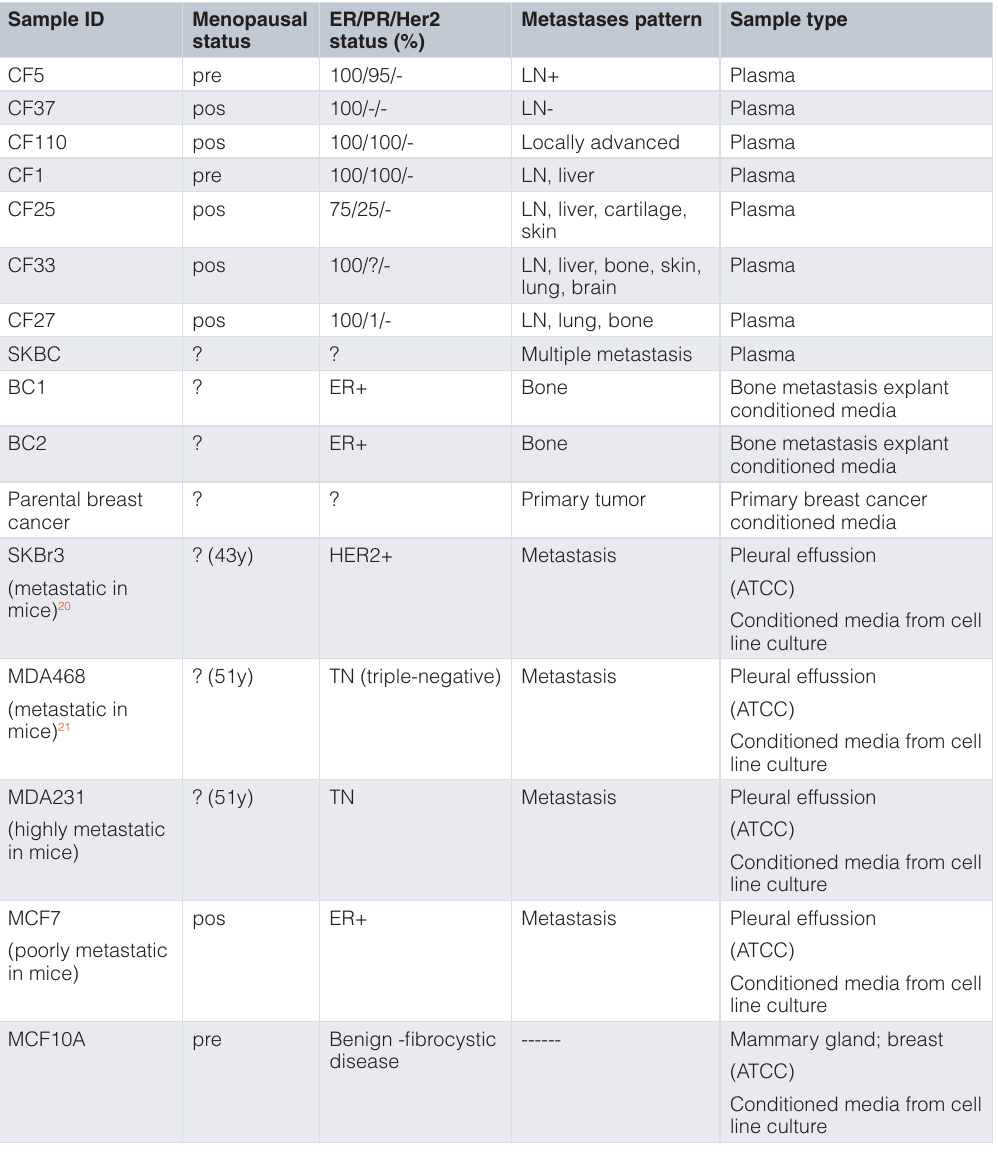
Table 1. Clinical data for different patient samples and cell